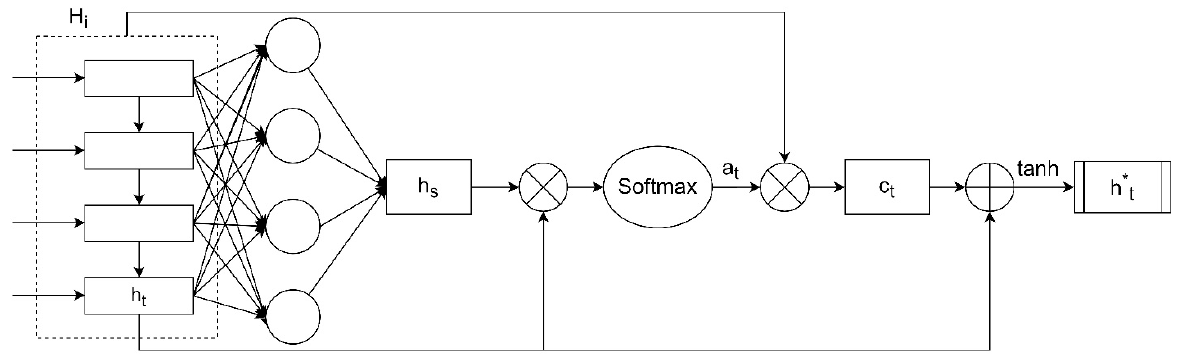
Figure 4. Schematic diagram of the attention mechanism structure. The attention mechanism assigns different weights to the D-dimensional feature vectors.